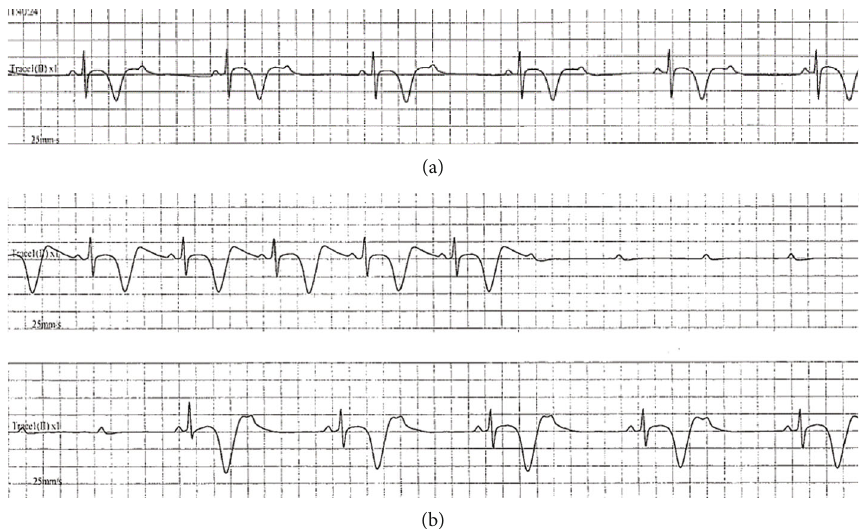
Figure 4: Electrocardiogram shows transient advanced atrioventricular block on hospital day 2 (a) and day 14